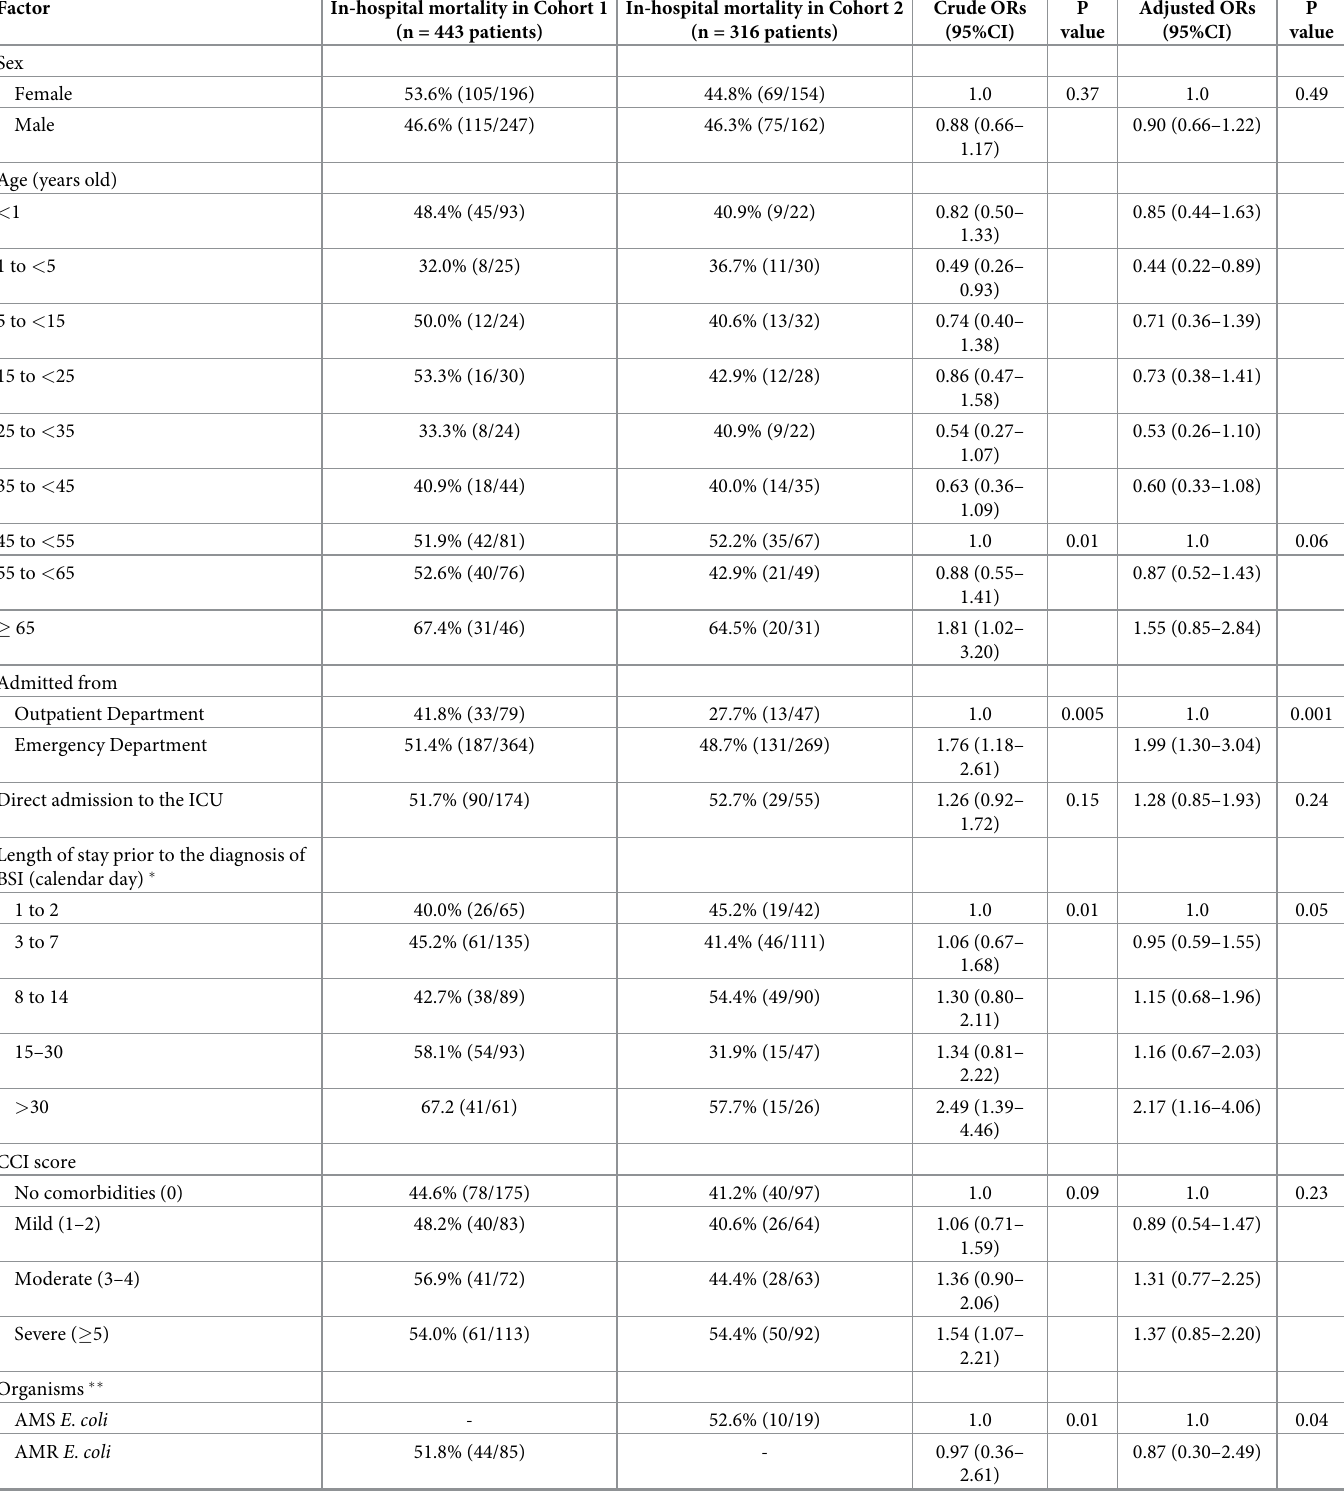
Table 2. Factors associated with in-hospital mortality in patients with AMR BSI compared with AMS